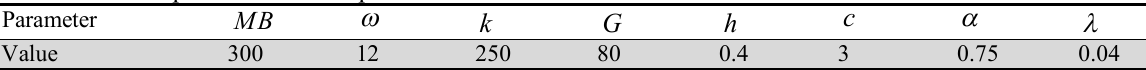
algorithm are represented in Table 3. In order to show the effect of related deterioration and advertisement parameters, Table 4 provides the computational results for different values of  and  . The value of the parameters of the problem